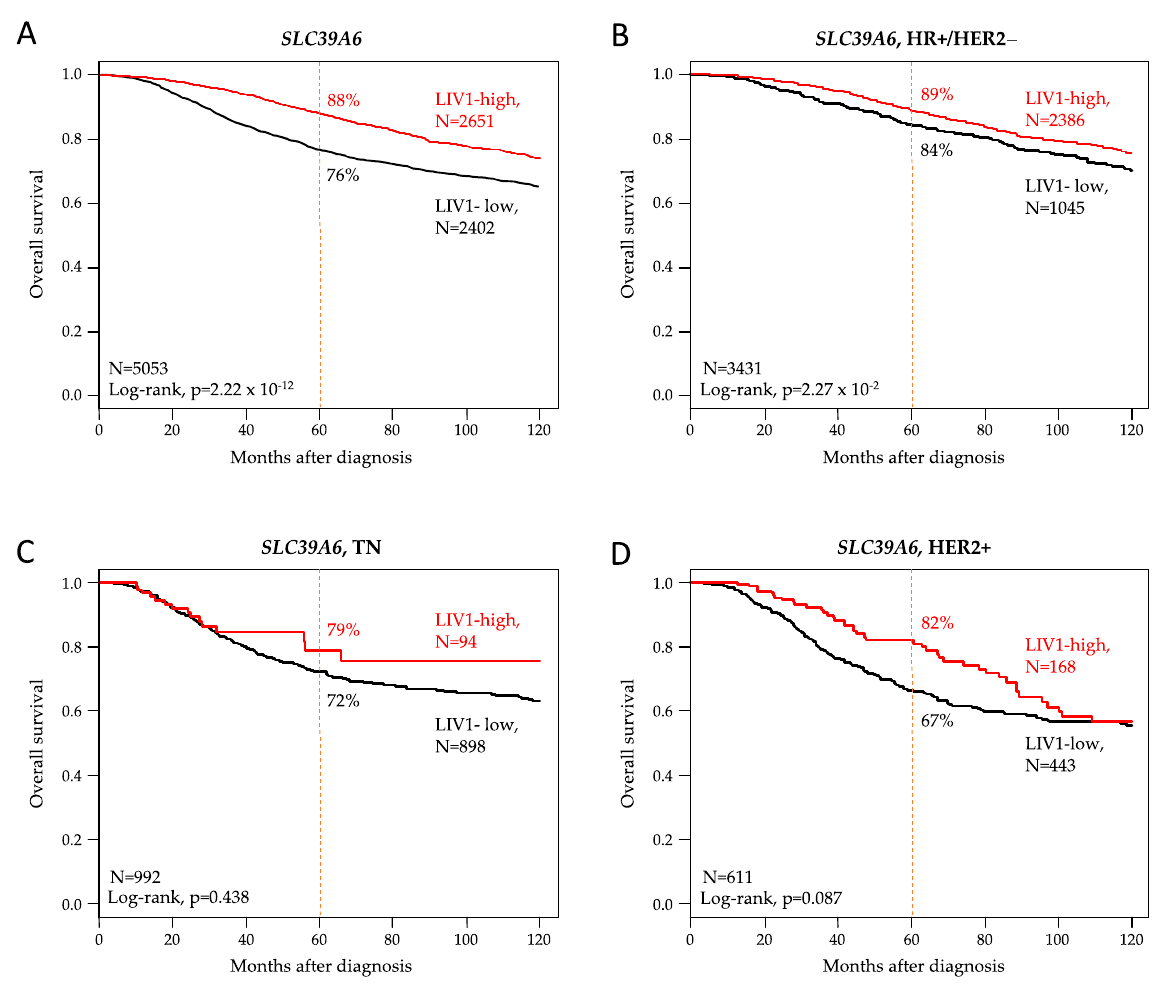
Figure 2. Prognostic value of LIV1 expression for OS in breast cancer. Kaplan–Meier OS curve according to high and low LIV1 mRNA expression in the whole population ( A ), in the HR+/HER2- patients ( B ), in the TN patients ( C ), and in the HER2+ patients ( D ). The corresponding Hazard Ratio for an OS event was 0.66 (95%CI 0.58–0.74). In uni- variate analysis (Table 3), pathological grade 2–3 ( p = 1.18 × 10 − 14 ), positive axillary lymph Table 2. Univariate- and multivariate analyses for DFS in the whole node status ( p = 4.14 × 10 − 31 ), pT2-T3 tumor size ( p = 9.81 × 10 − 21 ), and HER2+ and TN sub- types ( p = 3.53 × 10 − 23 ) were associated with shorter OS. In multivariate analysis, all the tested variables remained significant, including the LIV1 expression status ( p = 1.74 × 10 − 3 , Wald test), suggesting an independent prognostic value. Table 3. Univariate and multivariate analyses for OS in the whole population.